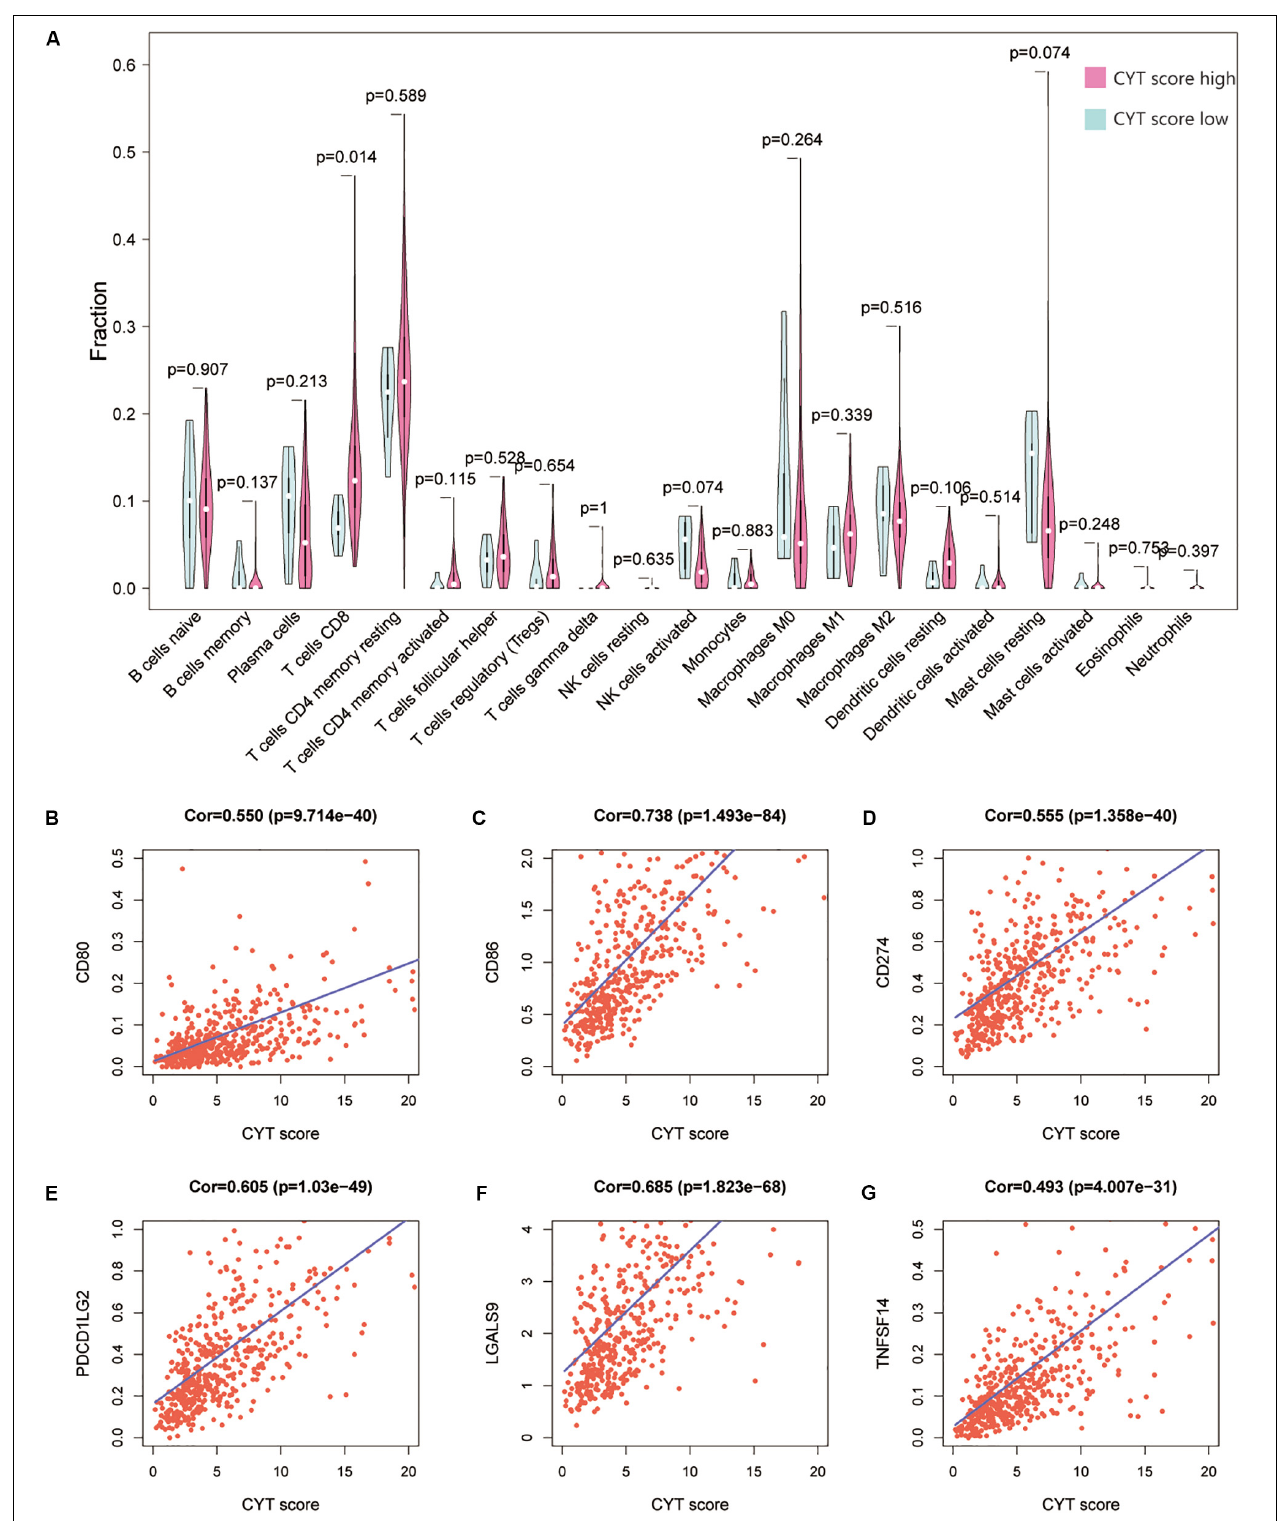
FIGURE 5 | (A) The Violin plot exhibits the difference between CIBERSOFT immune cell fractions between low CYT group and high CYT group by Wilcox t text. (B–G) There was a significant correlation between the CYT score and CD8 + T cell ligand, including CD80, CD86, PD-L1, PD-L2, LGALS9, and TNFSF14.